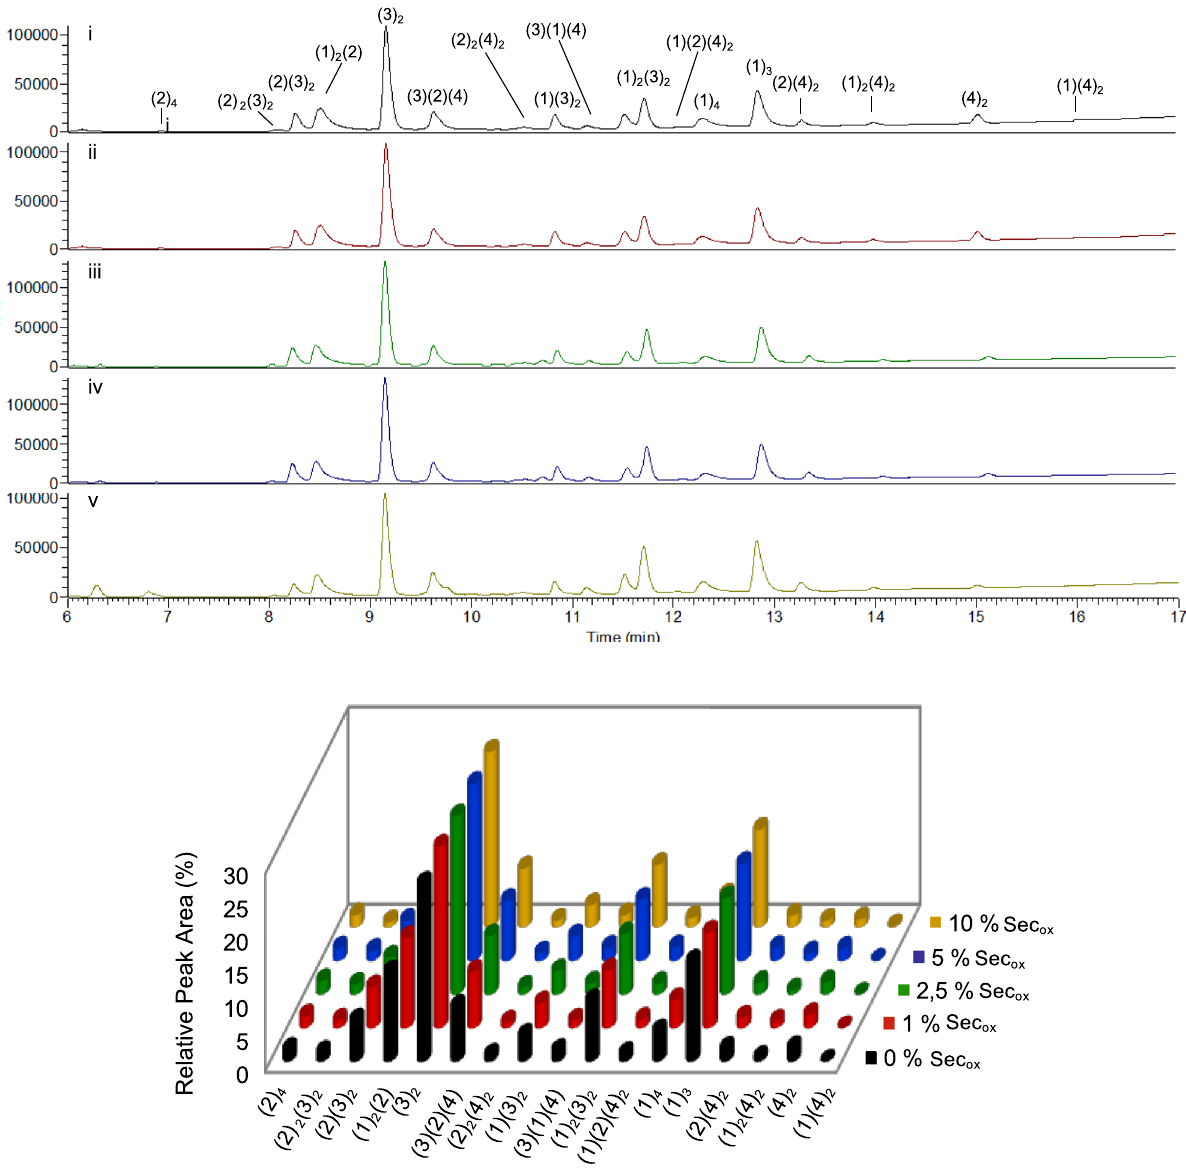
Fig. 5 Analysis of Sec ox percentages in a 4 building blocks DCL. a DCLs chromatograms showing different percentages of Sec ox . DCL conditions: building blocks (1 – 2) at 95 μ M concentration each and building blocks (3 – 4) at 190 μ M concentration each. Tris buffer 20 mM pH 7.8, 6 °C, (i) 0% mol as control DCL, 96 h (black), (ii) 1% mol (5.7 μ M) (red) in 72 h, (iii) 2.5% mol (14.25 μ M) (green) in 48 h, (iv) 5% mol (28.5 μ M) (blue) in 24 h, (v) 10% mol (57 μ M) (yellow) in 24 h. b Relative peak areas (RPAs) of the DCLs after equilibration in the absence and in the presence of different Sec ox percentages (Supplementary Table 1). Experiments were performed in